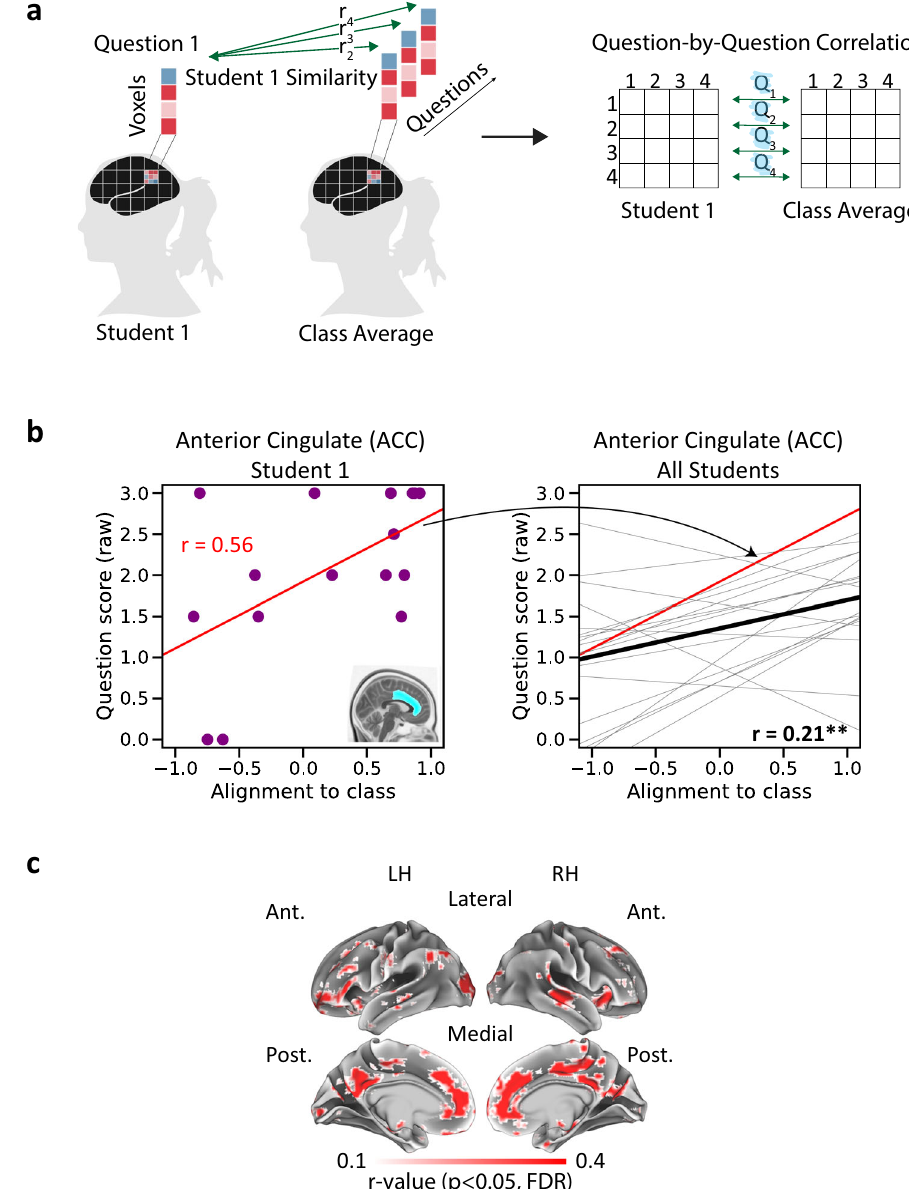
Fig. 5 Knowledge structure alignment during the exam correlates with performance. a Student and class knowledge structures are correlated on a question-by-question basis to derive knowledge structure alignment during the exam. Cell i, j in the student ’ s knowledge structure is the correlation between the student ’ s pattern for question i with the class pattern for question j. Student and mean class knowledge structures are then correlated on a row-by-row (question-by-question) basis. b Left, within-subject correlation between alignment-to-class and exam score in a single ROI, in a single student. Each violet dot represents a single question. Right, within-subject correlation between alignment-to-class and exam score in a single ROI, trendlines for all students shown. Red, the trendline of the student shown on the left. Black, mean across all students. Asterisks denote signi fi cant correlation (one-sided permutation test, corrected), * p < 0.05, ** p < 0.01. c Correlation between knowledge structure alignment-to-class and exam score, searchlight analysis results shown. Voxels showing signi fi cant correlation are shown in color (one-sided permutation test, p < 0.05, corrected). A control analysis for response length is shown in Supplementary Fig. 2c. Searchlight results for alignment-to-experts are shown in Supplementary Fig. 3. Note the correspondence between the alignment-to-class maps here and in Fig. 4. LH left hemisphere, RH right hemisphere, Ant. anterior, Post. A key role for medial DMN regions during learning . The sig- ni fi cance of DMN cortical structures in our results highlights the role these regions play during key stages of the learning process, from fi rst exposure to course video lectures to review of learned material (recap videos) and, fi nally, question answering during the exam (Fig. 6). Effects in these regions were robust, emerging